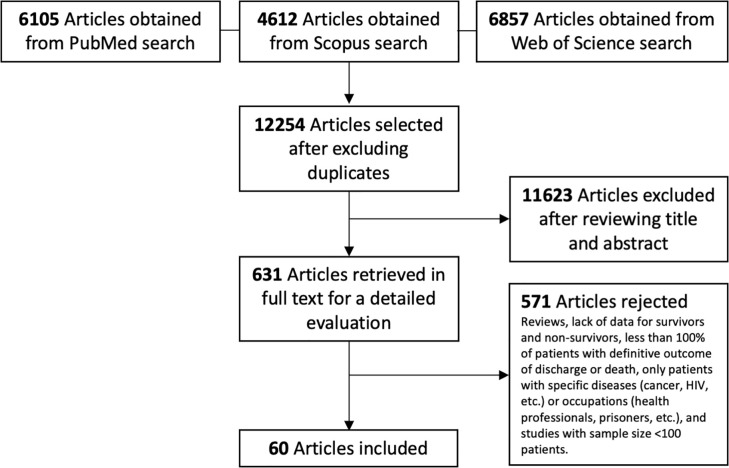
Flow diagram of the literature search and studies selection.